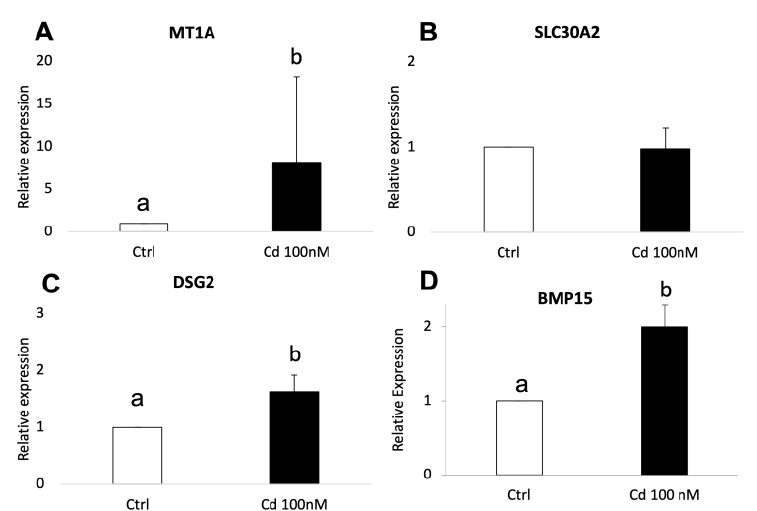
Figure 7. Relative expression of DEGs in CCs of prepubertal lambs evaluated by Real-Time PCR. MT1A ( A ), DSG2 ( C ) and BMP15 ( D ) were upregulated upon CC exposure to 100nM of CdCl 2 . No significative difference was found for SLC30A2 ( B ). Student’s t -test: a,b p < 0.05.